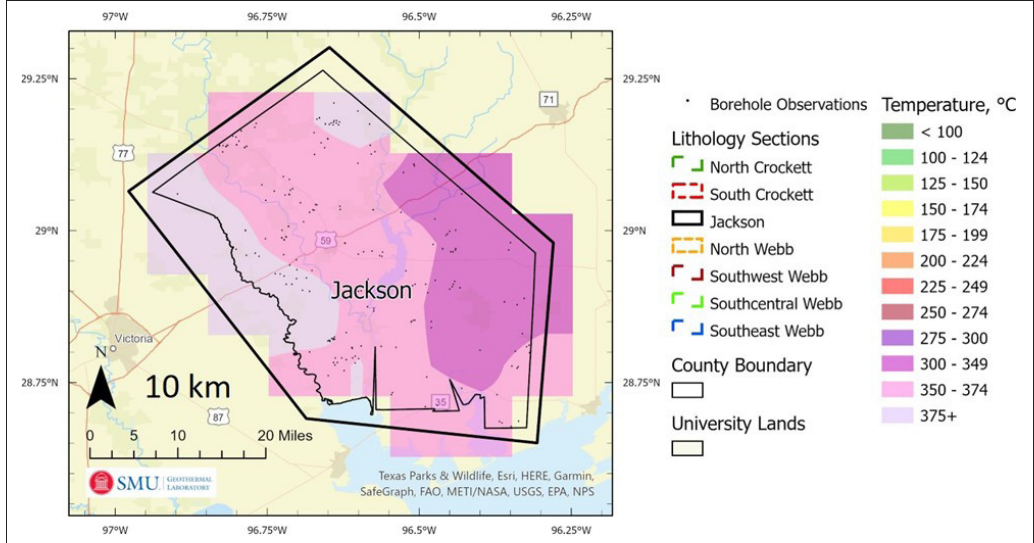
Figure 10. Modeled temperature at 10 kilometers (km; 32,800 feet) depth in Jackson County. While the entire county contains high temperatures, there are no direct temperature measurements at this depth and uncertainty is ±25%, which could be as high as ±100 °C (212 °F). The temperatures for 10 km range from 300 to 375+ °C (572 – 700